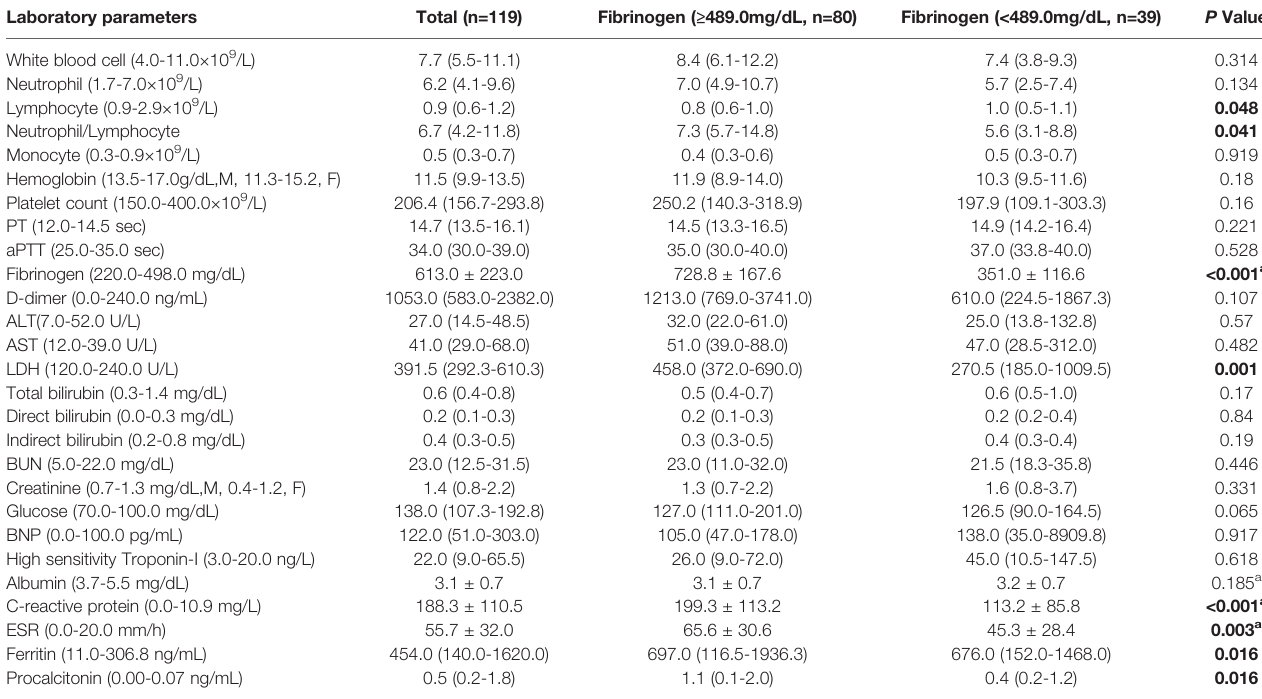
PT, prothrombin time; aPTT, activated partial thromboplastin time; ALT,alanine transaminase; AST, aspartate aminotransferase; LDH, lactase dehydrogenase; BUN, blood urea nitrogen; BNP, B-type natriuretic peptide; ESR, Erythrocyte sedimentation rate; F, female; M, male; a Student ’ s-t test, all other analyses were performed using Mann-Whitney U test. The bold values indicate P values < 0.05. Comparison of the in fl ammatory markers between patients with normal and elevated fi brinogen levels were further demonstrated in Figure 2 . However, comparison of other coagulation markers and cardiac markers between patients with normal and elevated fi brinogen levels did not show no signi fi cant difference.